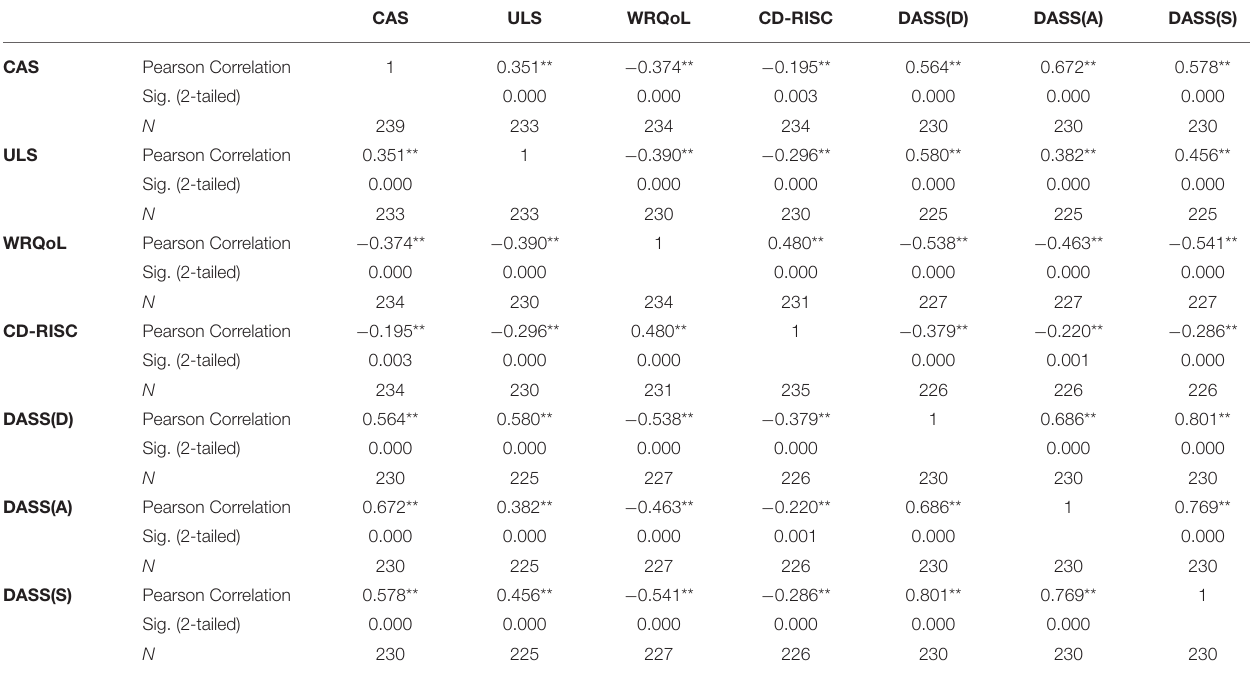
TABLE 2 | Correlation between psychometric scales’